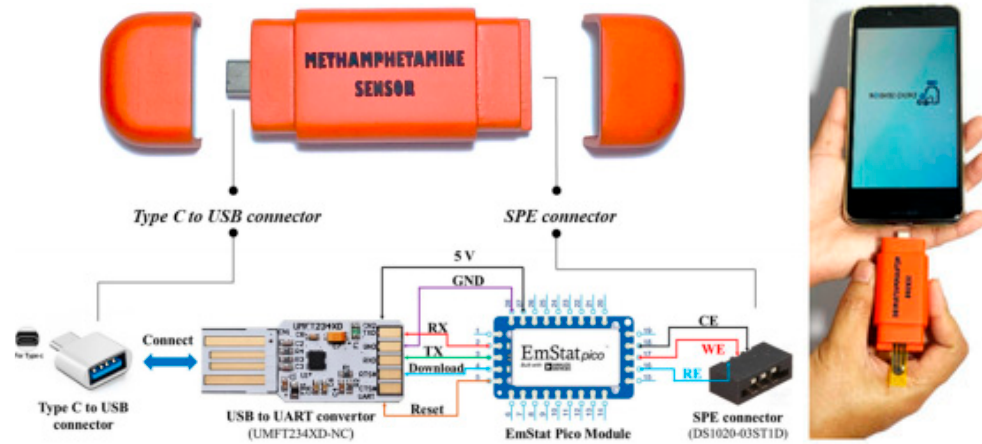
Figure 7. A portable electrochemical device containing a fully functional EmStat Pico potentiostat connected with a USB to a UART convertor to interface with a type-C USB connection and an SPE connector [52]. Reused from MDPI under a Creative Common CC BY license.